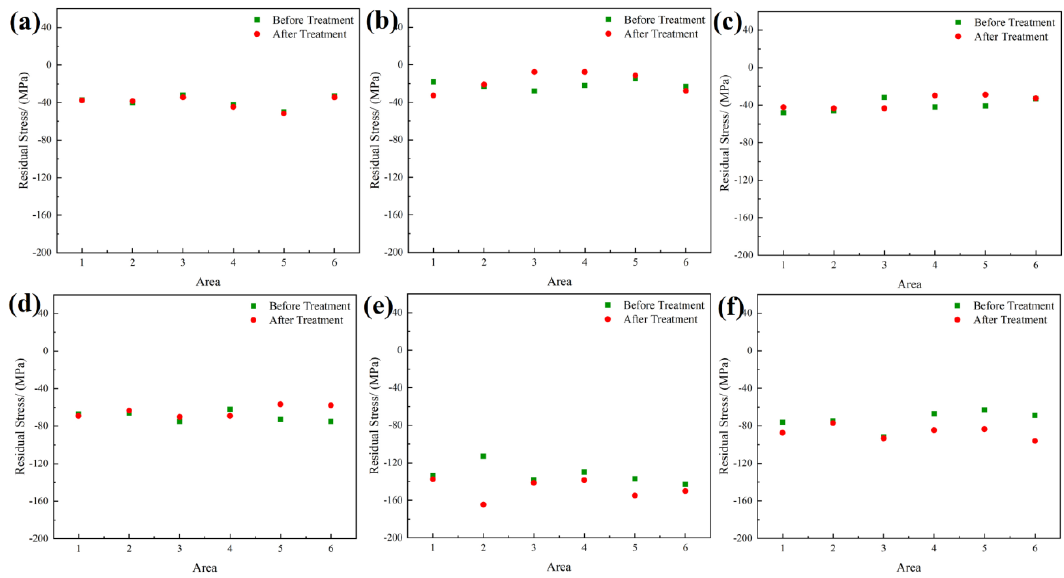
Figure 7. Residual stress before and after treatment at different magnetic fields. ( a ) 0 T; ( b ) 1.0 T; ( c )